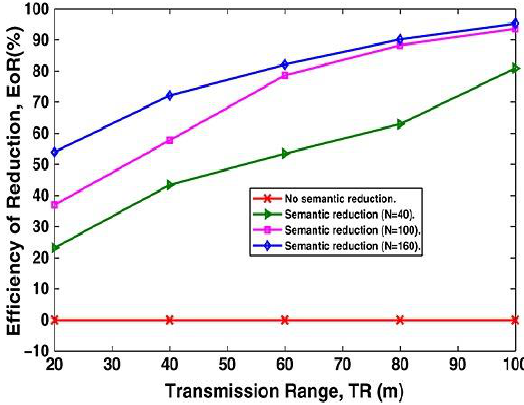
Fig.15. Impact of transmission range on efficiency of reduction